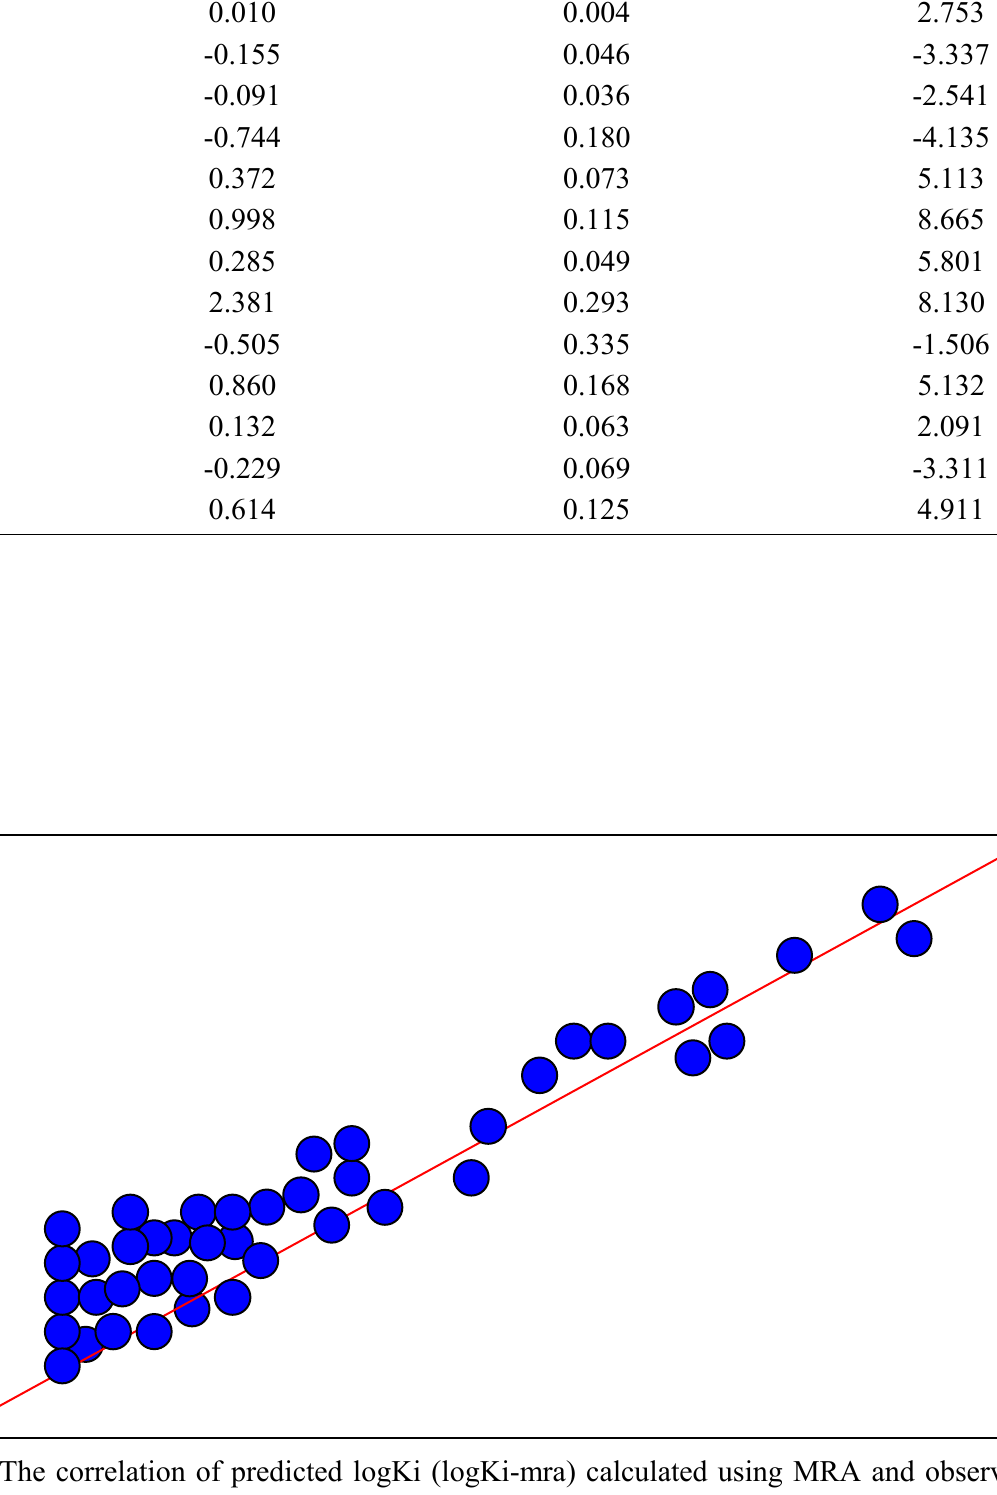
Figure 3. The correlation of predicted logKi (logKi-mra) calculated using MRA and observed logKi